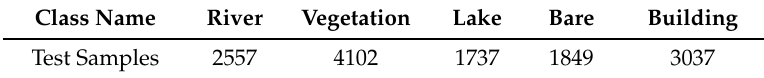
Table 1. Details of the samples for the Wuhan TM image.